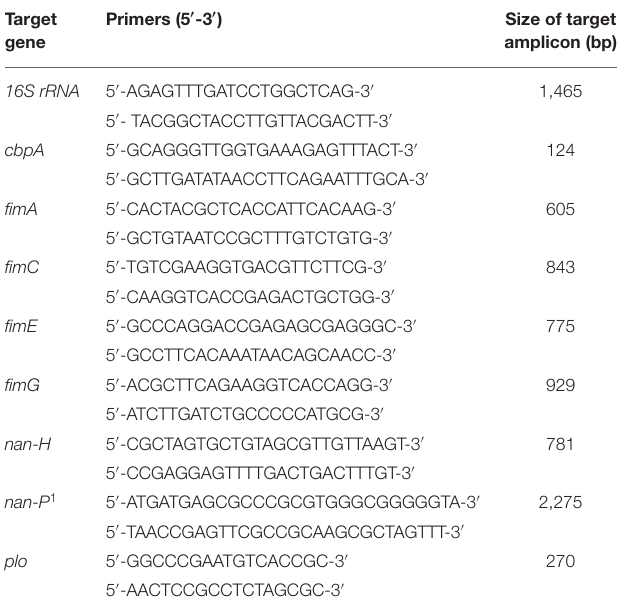
TABLE 1 | 16S RNA and the virulence factor genes used in this study. Target